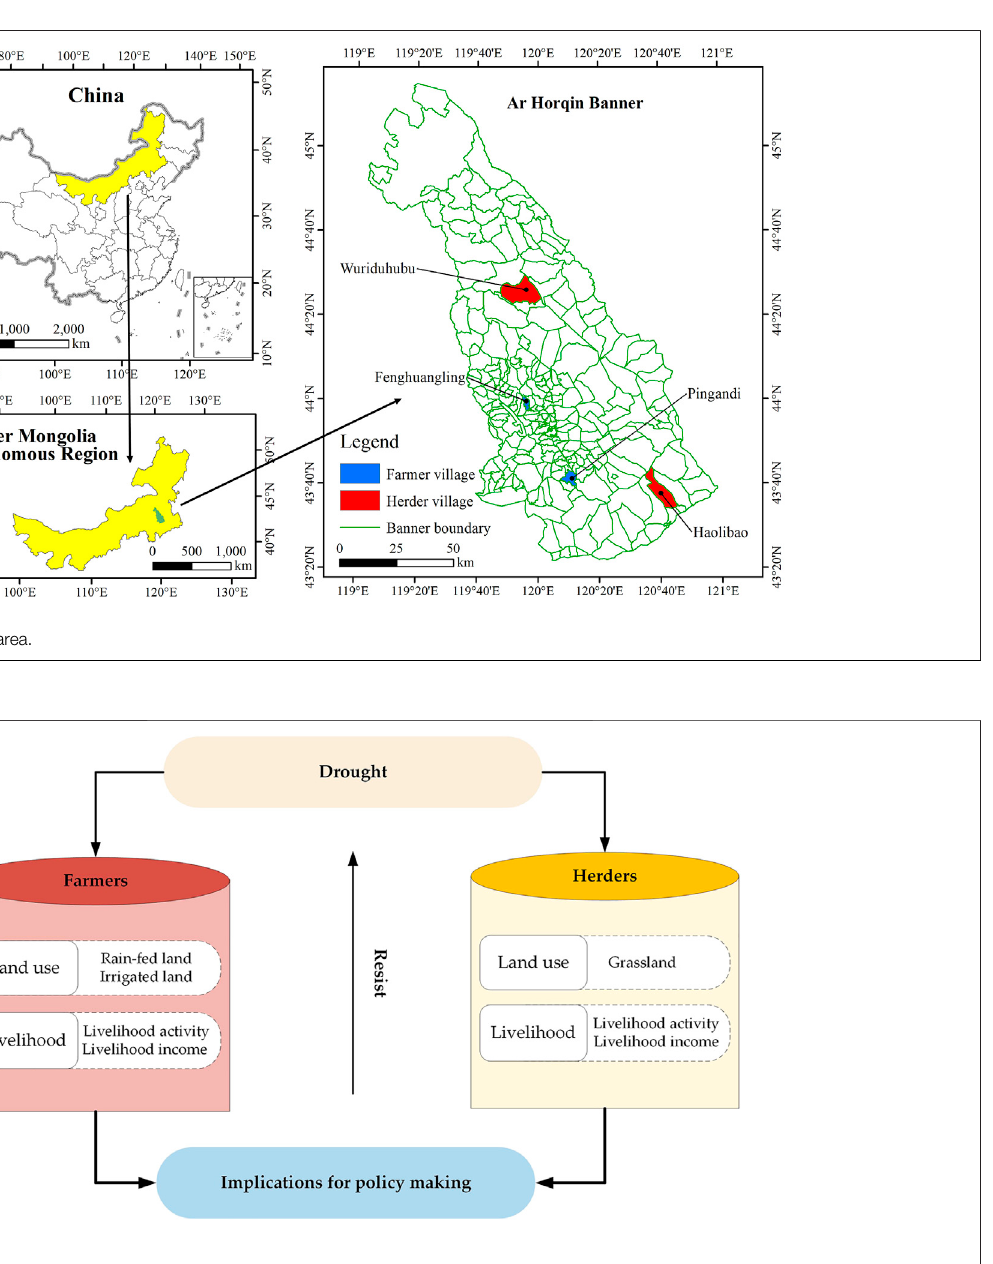
FIGURE 2 | Research